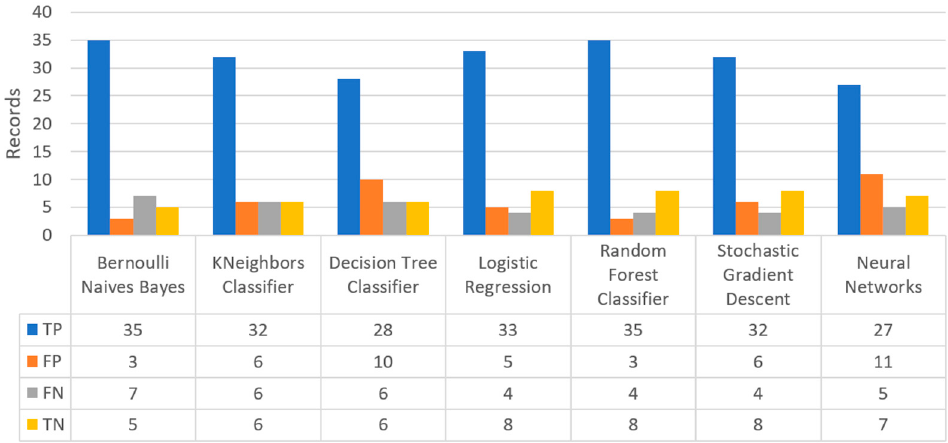
Figure 22. Confusion matrix of prediction results for heart failure use case.